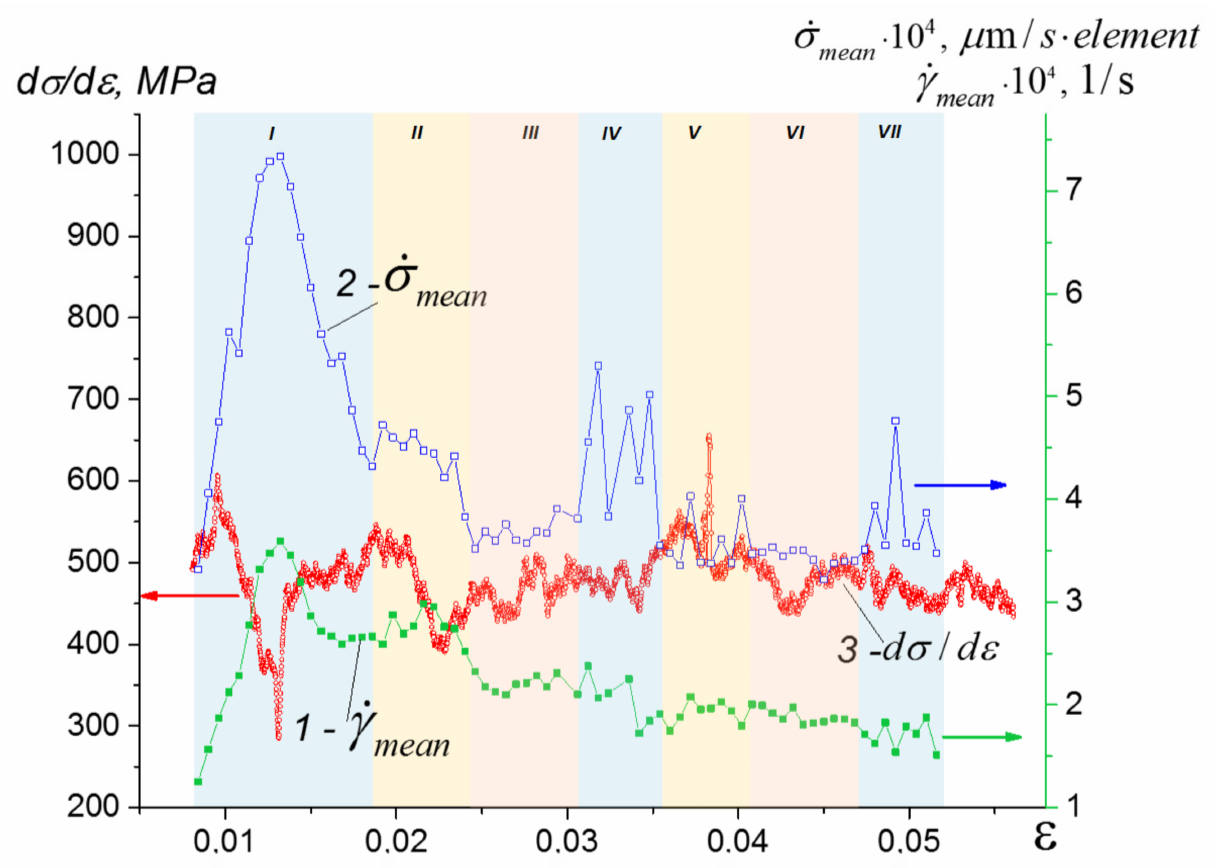
. γ mean (1) averaged over the vector field area, mean squared deviation for the